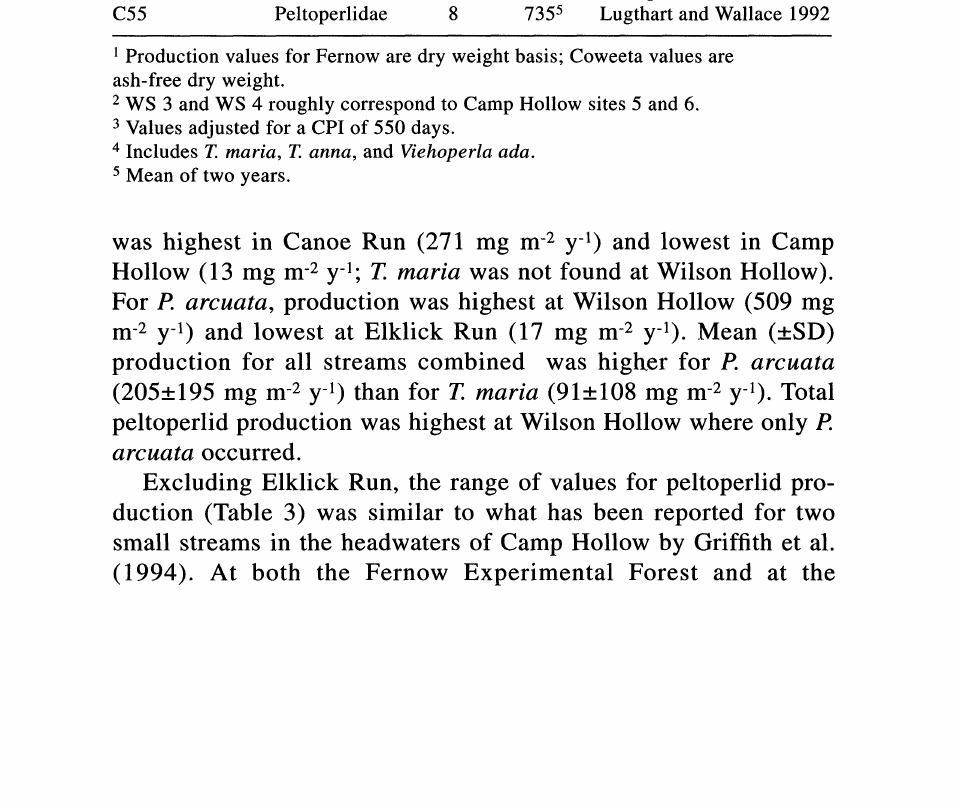
Lugthart and Wallace